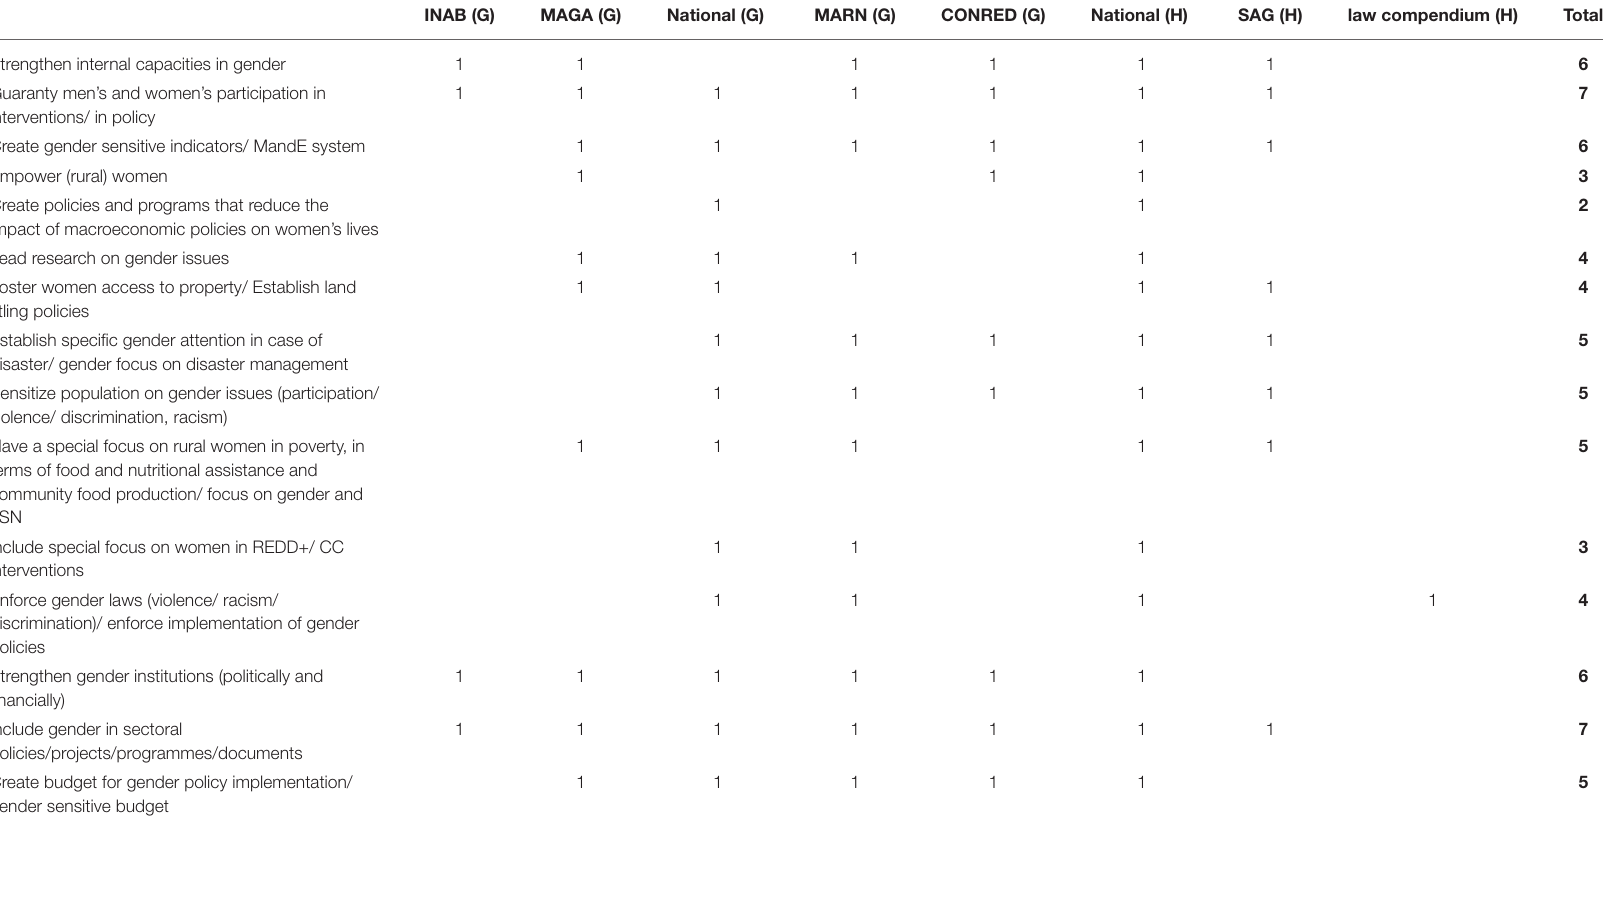
TABLE 4 | Lines of action to support women’s mainstreaming in gender policy